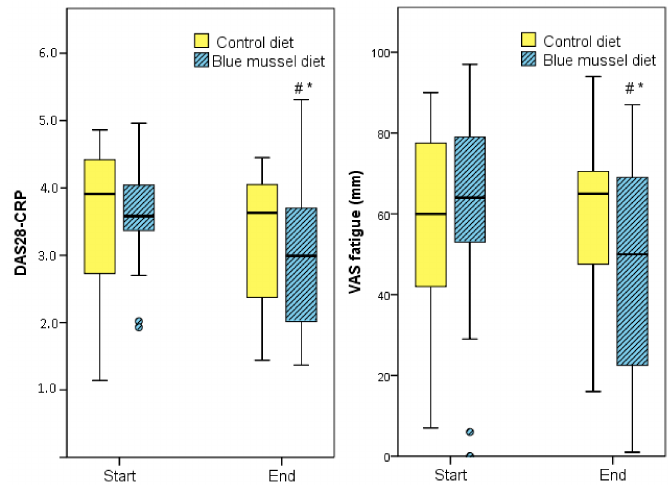
Figure 2. DAS28-CRP and visual analog scale (VAS) fatigue before and after intervention diets. DAS28-CRP. * Significant difference between the diets p = 0.048. # Significant difference between before and after the diet p = 0.007. VAS fatigue. * Significant difference between the diets p = 0.021. # Significant difference between before and after the diet p = 0.035.